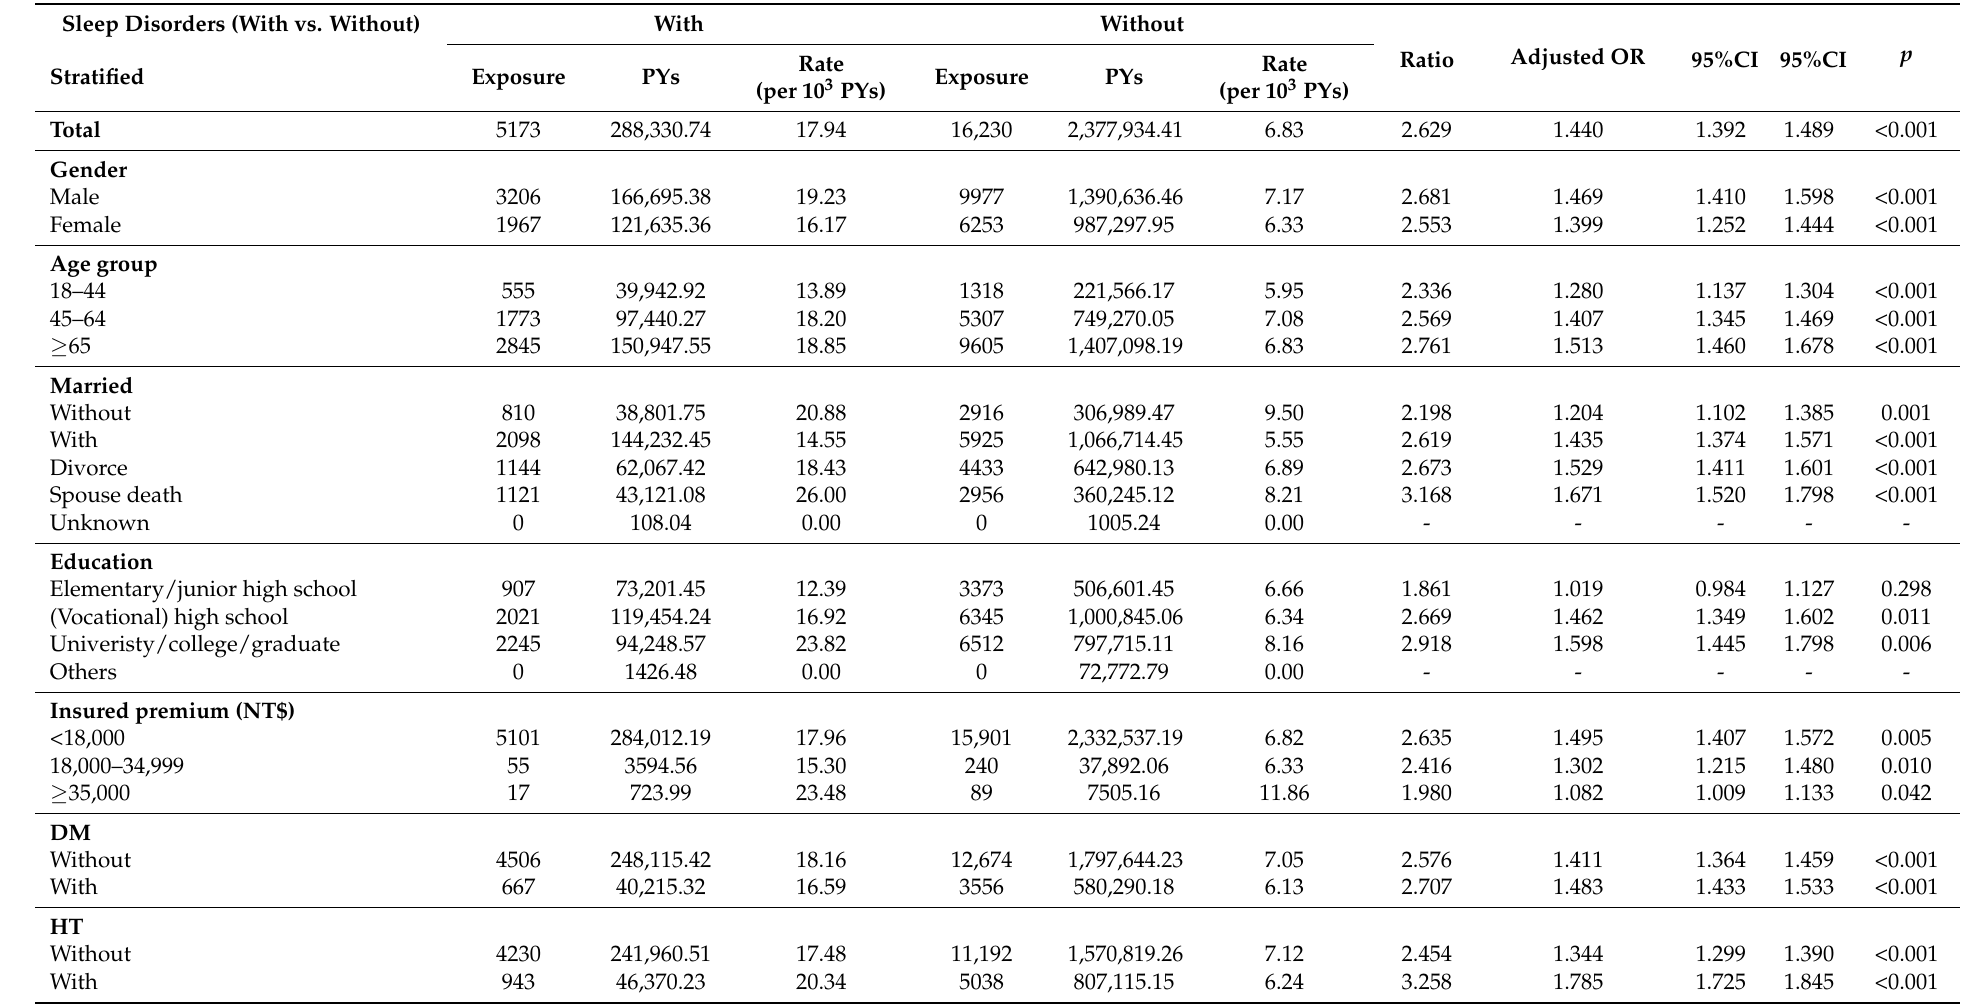
Table 3. Factors of cancers stratified by variables listed in the table by using conditional logistic regression. Sleep Disorders (With vs.